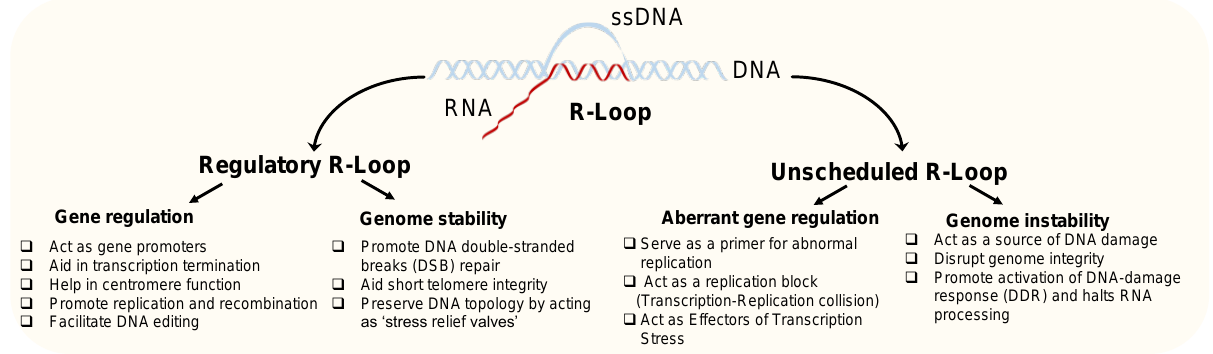
Figure 1. Roles of Regulatory and Unscheduled R-loops. Regulatory R-loops are intermediates required for gene regulation and genome stability ( left ). R-loops regulate gene activity by modulating transcrip- tional activity, replication, recombination, centromere function, and DNA editing. R-loops are also involved in stabilizing the genome by promoting the repair of DNA double-strand breaks (DSB) and short telomere structures. Absence of timely removal or prevention of unwanted R-loop accumulation results in the formation of unscheduled R-loops ( right ). Unscheduled R-loops are a source for aberrant gene regulation (by serving as a primer for aberrant replication, enhancing transcription–replication collision, and acting as an effector of transcription stress) and contribute to the instability of the genome (by inducing DNA damage). In turn, unscheduled R-loop formation promotes the DNA- damage response (DDR) activation and halts RNA processing to allow for genome repair [29].